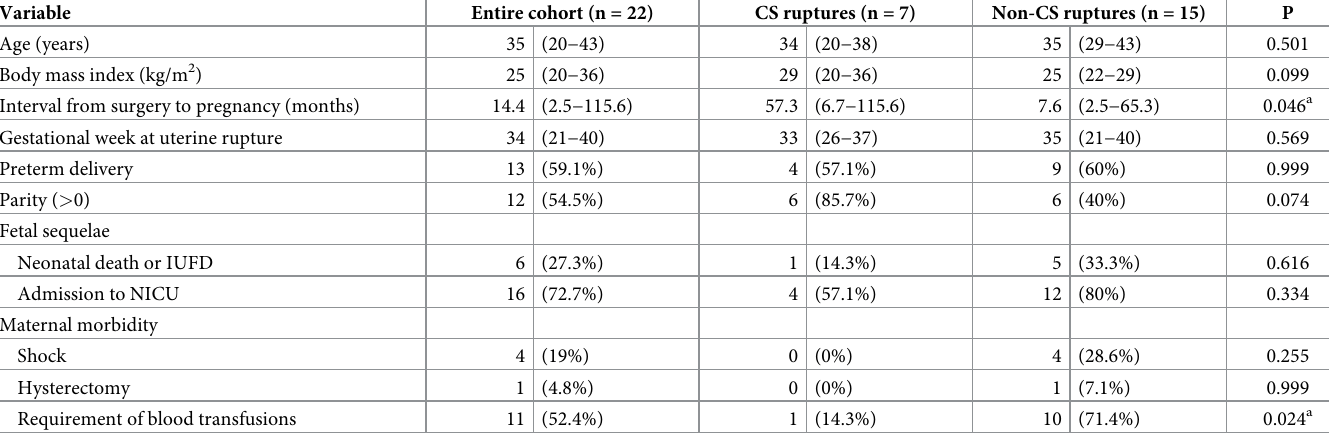
Table 1. General characteristics, fetal sequelae, and maternal morbidity of women with uterine rupture classified according to the presence or absence of a cesarean